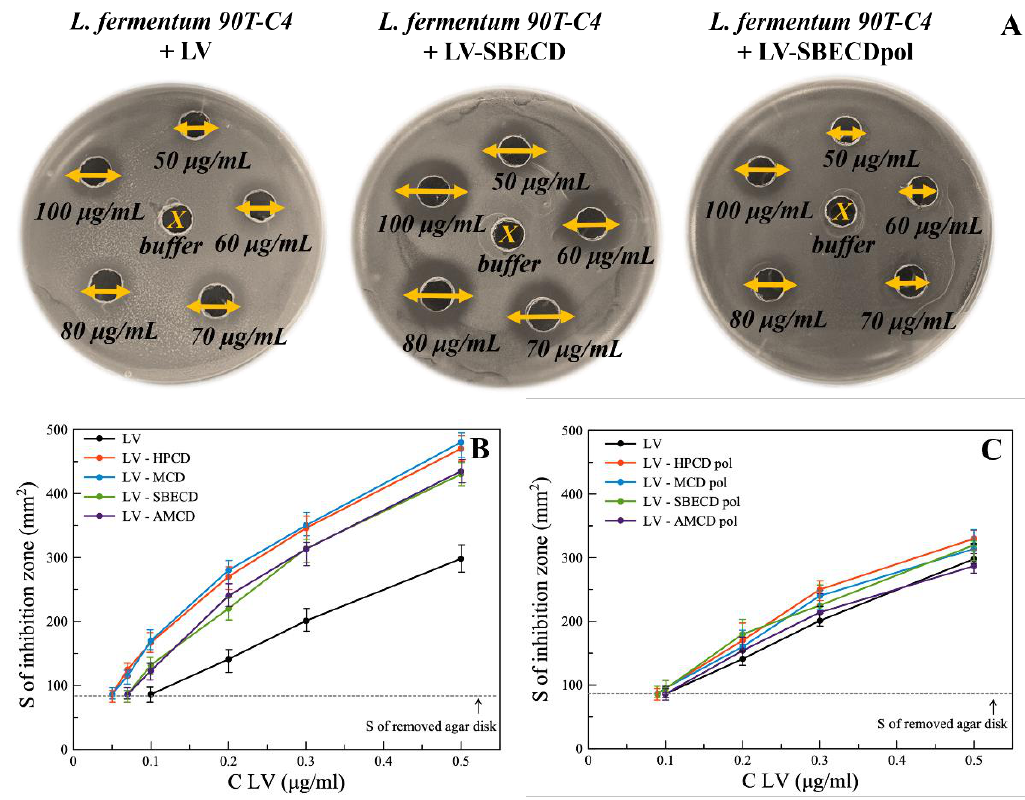
Figure 4. ( A ) The diameters of inhibition zones (mm) on Petri dishes with free LV and its complexes with SBECD and SBECDpol in the concentration range 50 –100 μg/mL, agar well diffusion method, L. fermentum 90T-C4 pH 7.4 (0.02 M Na-phosphate buffer solution), 37 °C, 24 h of incubation. ( B,C ) The area of inhibition of E. coli ATCC 25922 bacterial growth depending on the concentration of the drug, agar well diffusion method, pH 7.4 (0.02 M Na-phosphate buffer solution), 37 °C, 24 h of incubation.